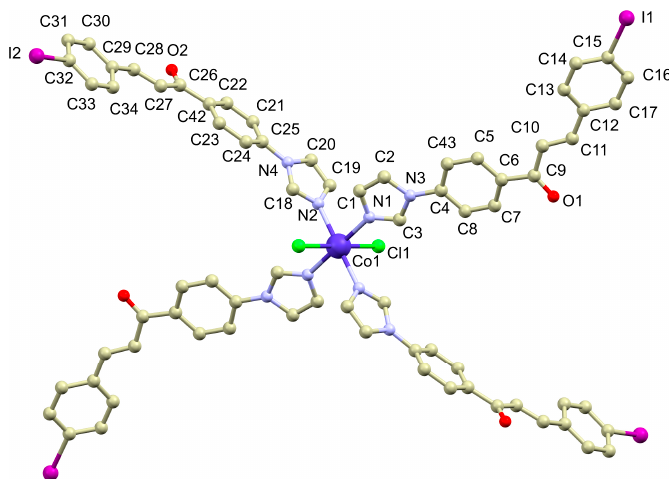
Figure 2. Molecular structure of 1b. Color code: grey (C), green (Cl), dark blue (Co), violet (I), light blue (N) and red (O). Hydrogen atoms are omitted for clarity. Selected bond lengths (in Å) and angles (deg.): d (Co1 − N1) = 2.121(3), d (Co1 − N2) = 2.162(3), d (Co1 − Cl1) = 2.4880(9), N1 − Co1 − N1 i = N2 − Co1 − N2 i = Cl1 − Co1 − Cl1 i = 180.0, N1 − Co1 − N2 = 88.15(12), N1 − Co1 − Cl1 = 92.26(9), N1 − Co1 − Cl1 i 87.74(9), N2 − Co1 − Cl1 i = 90.14(9), N2 − Co1 − Cl1 = 89.86(9). Symmetry code: (i) = 1 -x, 1 -y, 1 -z.